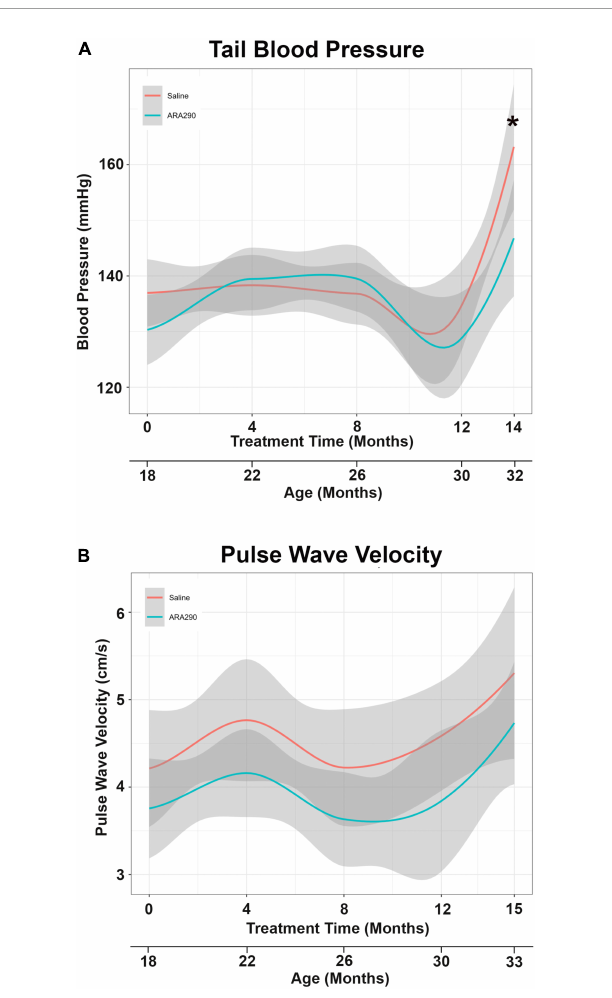
FIGURE3 Loess smooth curve (Red = Saline, Blue = ARA290) with 95% confidence intervals (gray) depicting the age-associated changes in tail blood pressure (A) and pulse wave velocity (B) . The final tail blood pressure reading was collected 1 month prior to the experiment endpoint. Statistically significant interactions between treatment groups are shown (* P <